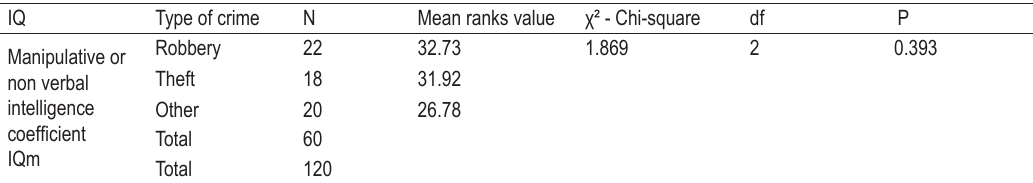
TABLE 7. Testing the signi fi cance of IQm differences between subgroups of non-homicide inmates considering the type of crime committed using Kruskal-Wallis